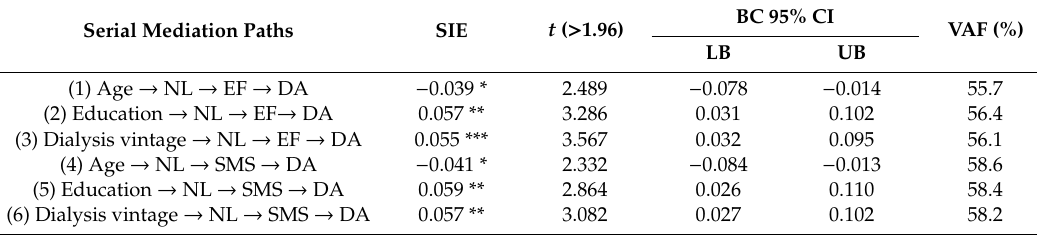
Table 5. Bootstrapping Result for Serial Mediation ( n = 218).